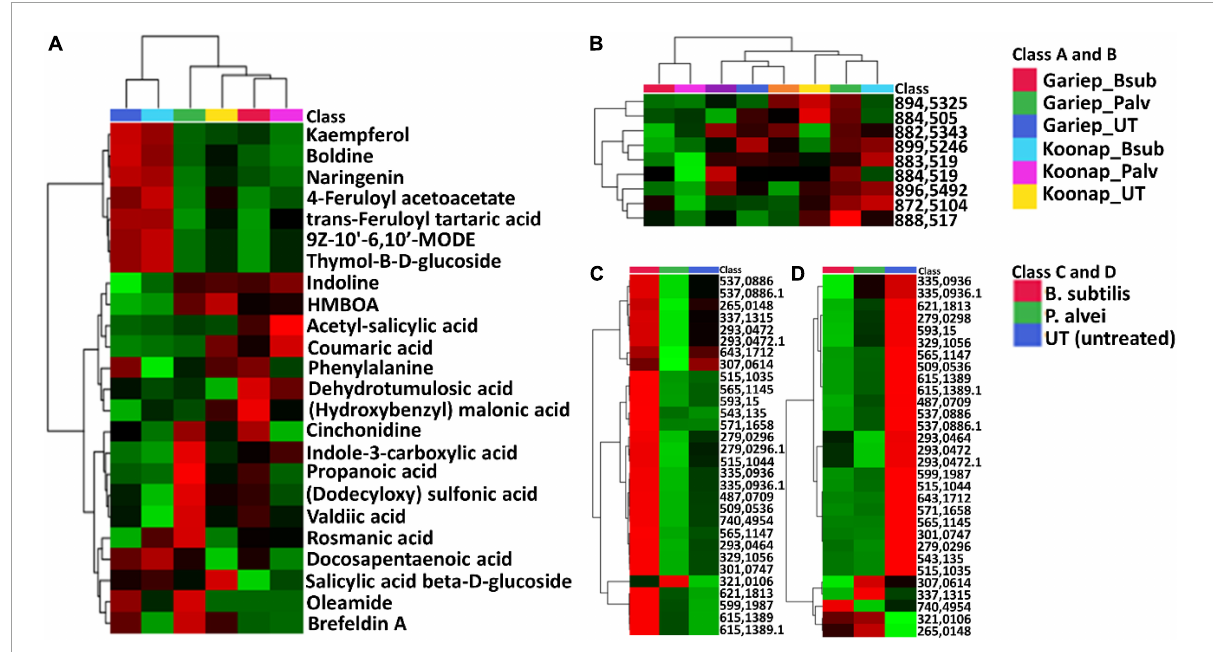
FIGURE4 Differential quantitative profiles of annotated and non-annotated metabolites from selected main classes (phenylpropanoids, polyketides, lipids, and lipid-like molecules). The interactive heatmaps were generated from the average peak intensities of the metabolites ( n = 9) in MetaboAnalyst. The data were median-normalized, log transformed and Pareto -scaled. (A) Shows a heatmap of putatively annotated metabolites from the rhizosphere of plant growth-promoting rhizobacteria (PGPR)-treated and untreated Koonap and Gariep cultivars. Metabolite annotations were aided by MS-DIAL and further validated through a level 2 classified Metabolomics Standard Initiative (MSI-2). Unidentified metabolites from significant classes contributing to observed variation in the plant treatment are displayed in (B) for lipids and lipid-like molecules. Phenylpropanoids and polyketides are shown in (C) and (D) for Koonap and Gariep,